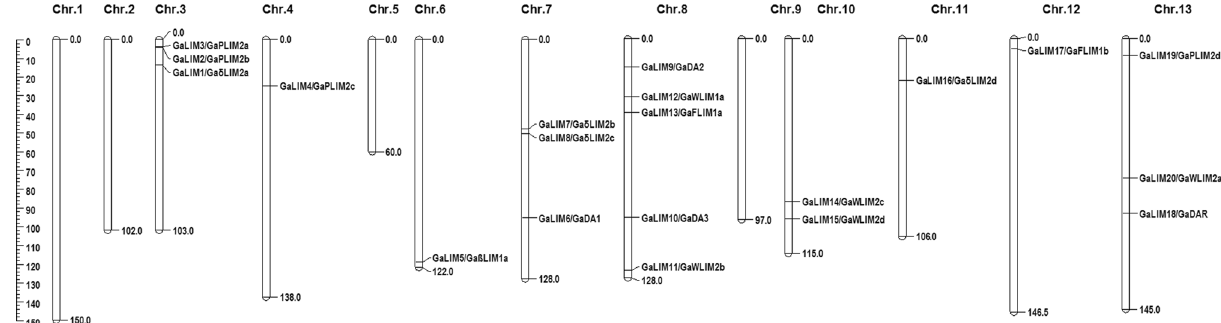
Figure 2. Chromosomal localization of GaLIM genes. (MapChart software version 2.30; https:// www. wur. nl/ en/ show/ Mapch art. htm).